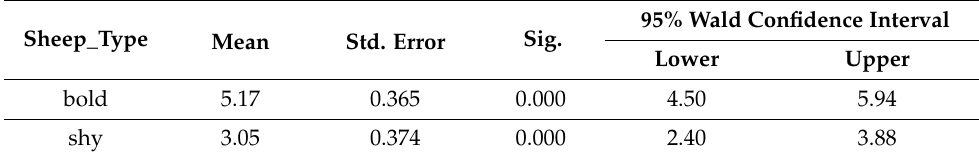
Table 6. Estimates of duration (in seconds) by personality type.